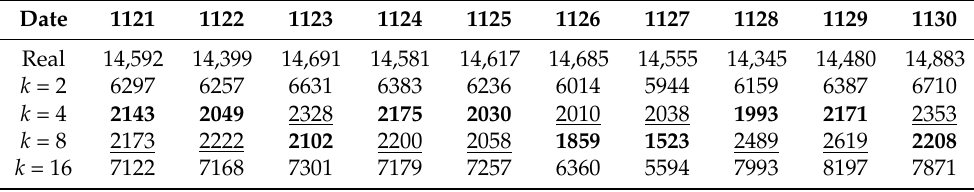
Table 2. The average pickup waiting time (/s) in CTPURec with different k .